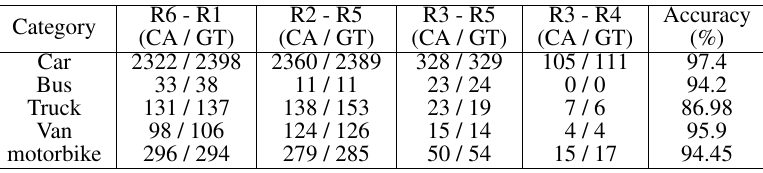
Table 5. The framework results of scenario 4.